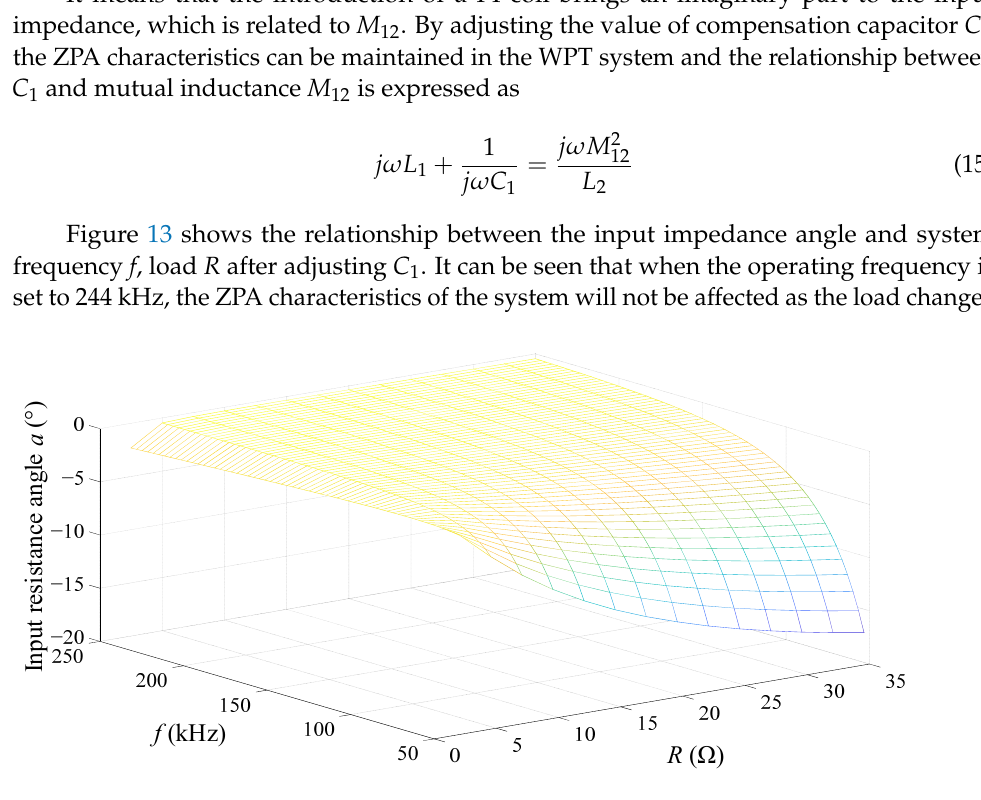
Figure 13. The relationship between input impedance angle α and system frequency f , load R after adjusting C 1 .